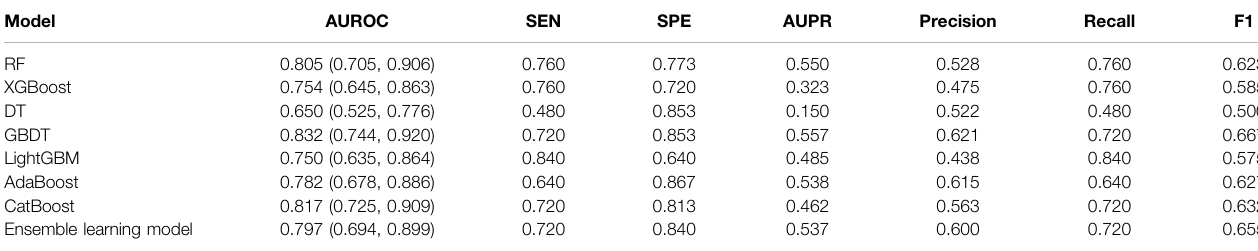
TABLE 5 | Eight algorithms ’ model performance in the test cohort. Model AUROC